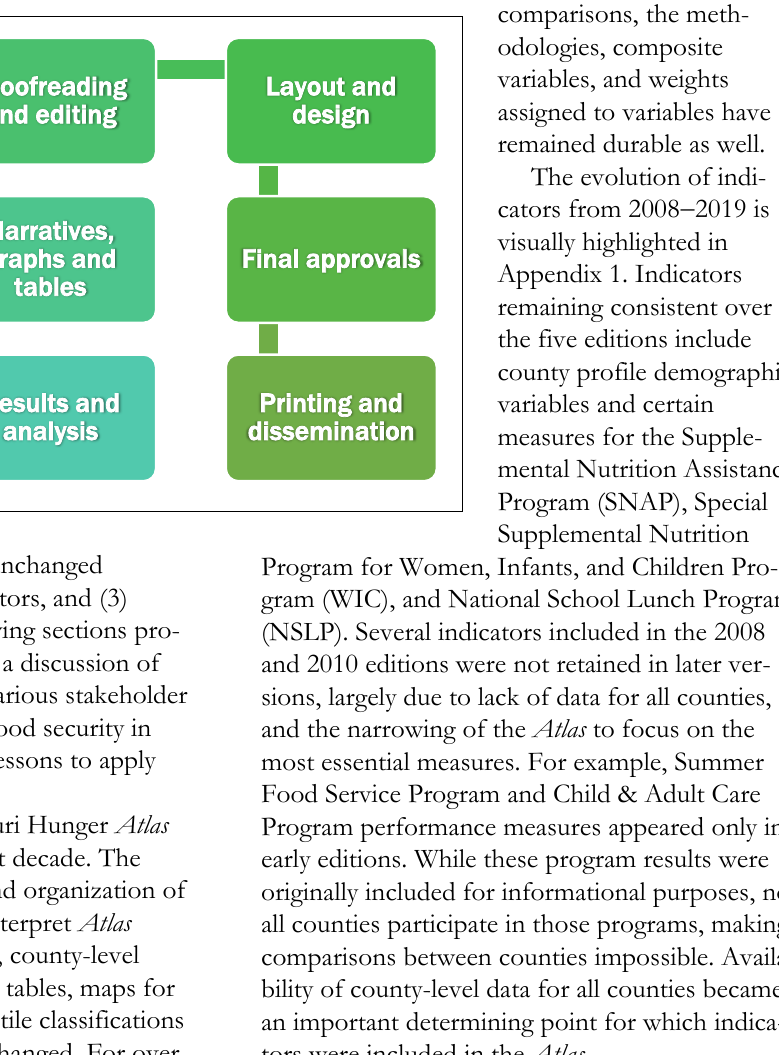
Table 1. Missouri Hunger Atlas Indicator Selection Criteria